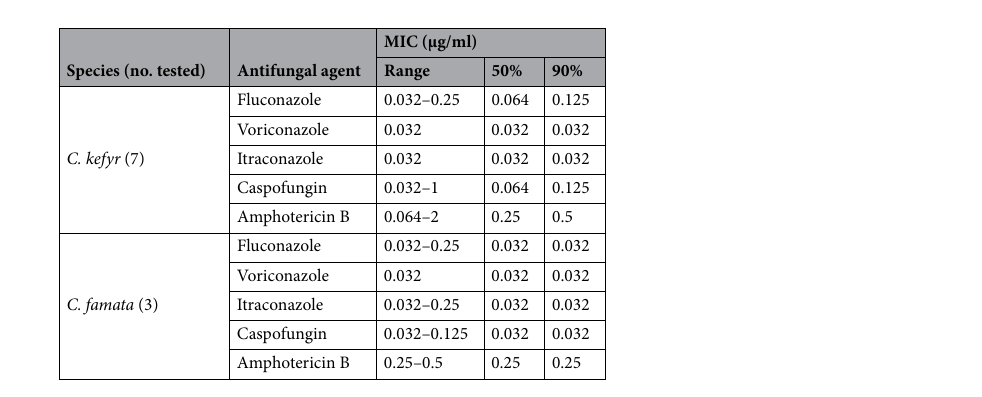
Table 3. Susceptibilities of different antifungals to C. kefyr and C. famata.